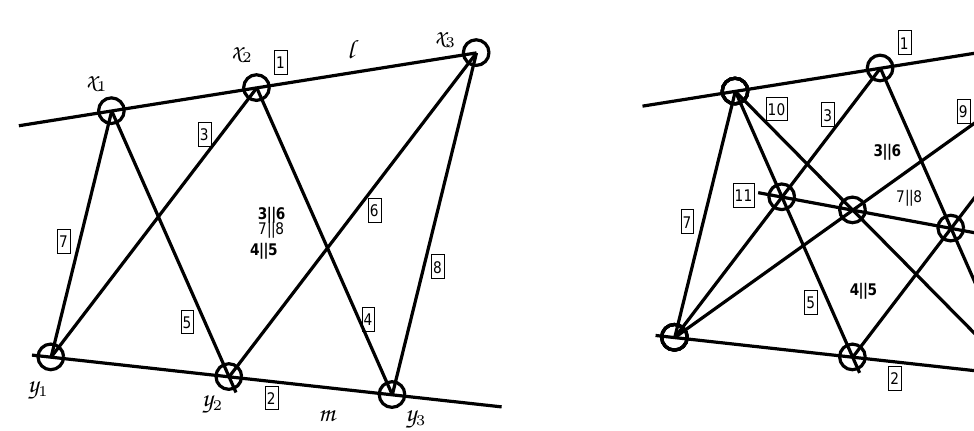
Figure 3. The construction of Pappus’s hexagon featuring nine constraints for the straight lines: Six times concurrence (‘ (cid:12) ’) and three times parallelism (‘ (cid:107) ’). The constraint ‘7 (cid:107) 8’ has been re- cognized to be redundant.